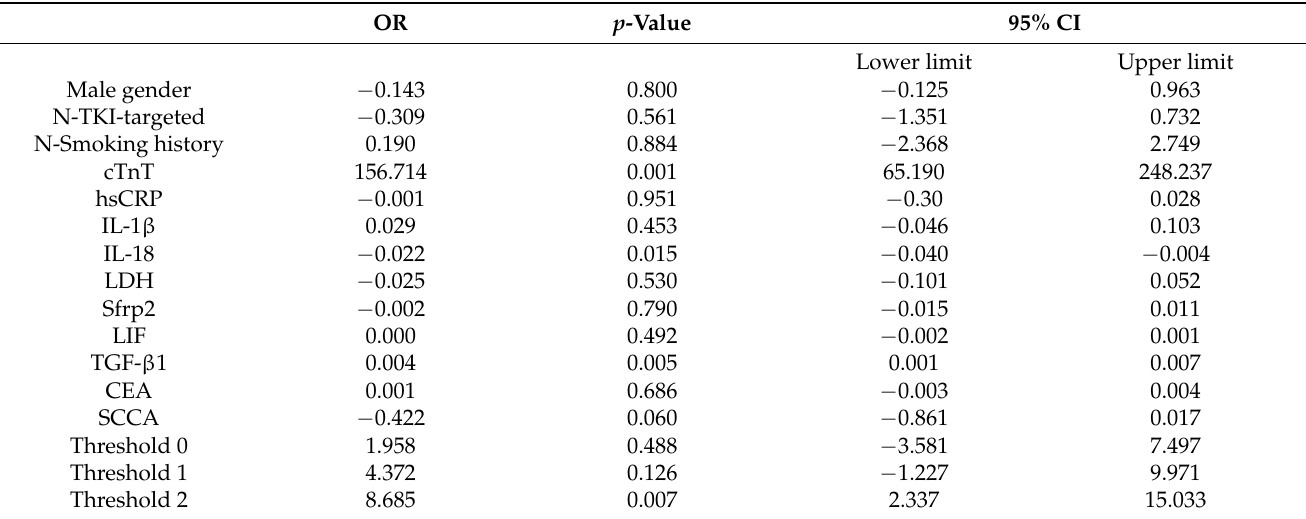
Table 3. Ordinal logistic regression results about the association between inflammatory biomarkers and preclinical cardiovascular injury in NSCLC patients.